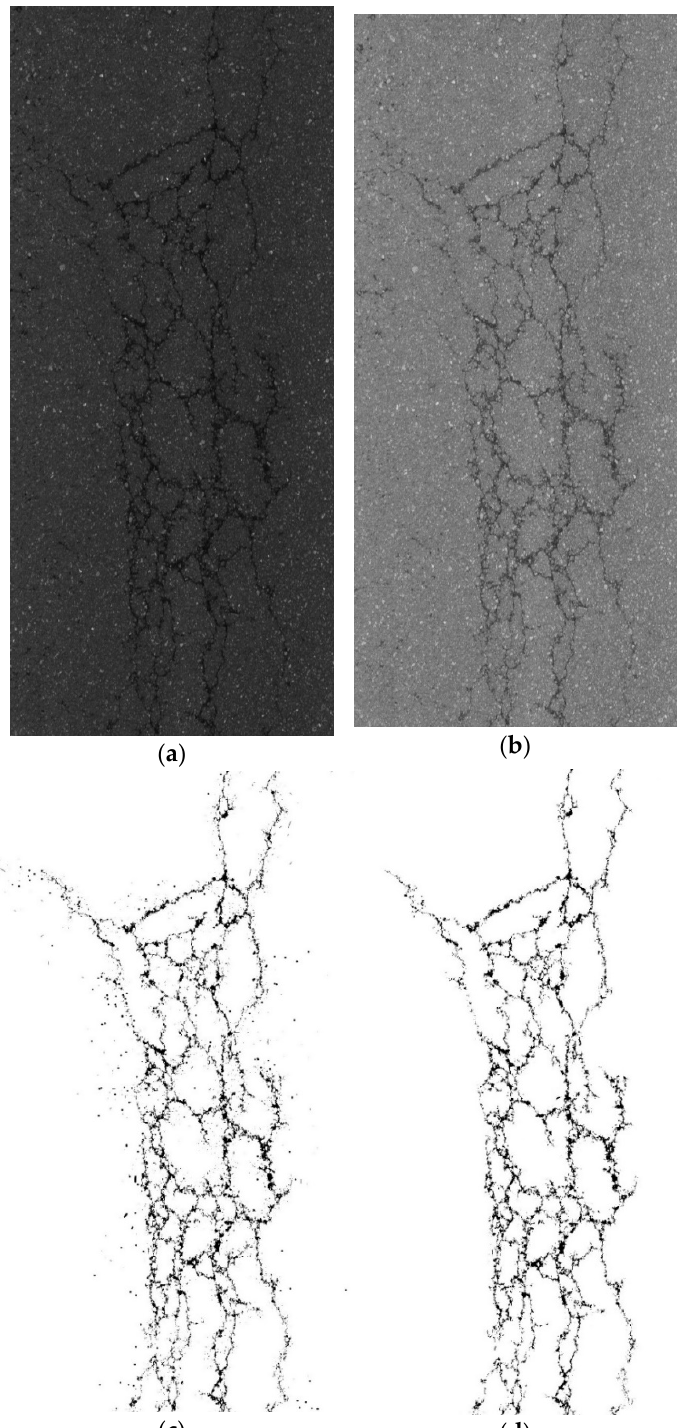
Figure 24. Comparative experiment of map crack segmentation. ( a ) original images, ( b ) image en- hanced by guided filtering and Retinex method, ( c ) images generated by traditional k-means clus- tering algorithm, ( d ) ours.